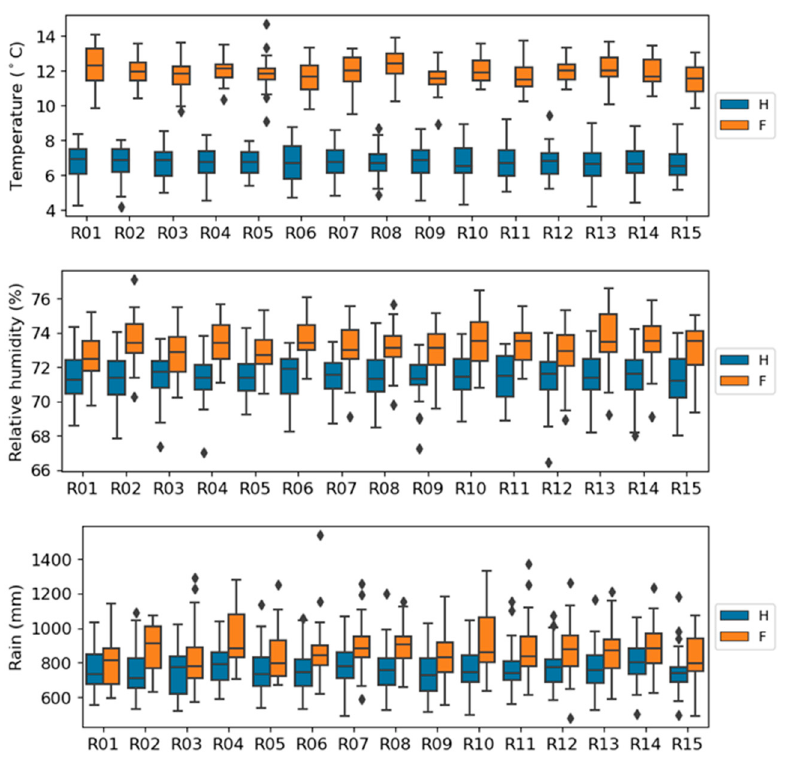
Figure 2. Boxplots of the annual average temperature and relative humidity, as well as the annual sum of horizontal rain for runs R01–R15 of the historical (H) and future (F) time periods in the city of Ottawa. Each run comprises 31 consecutive years.